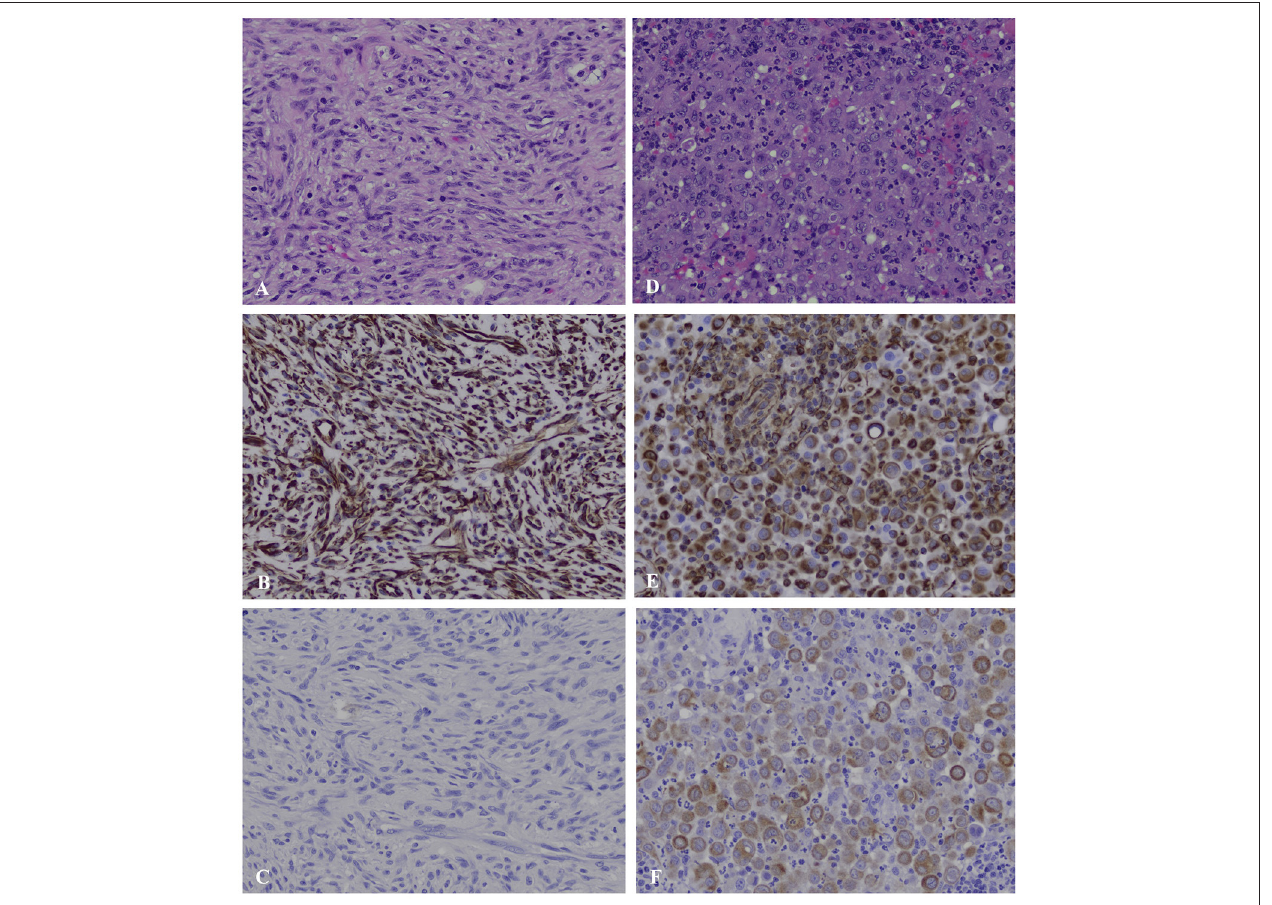
FIGURE 2 | Mediastinal mass (A–C) and sternal lymph node (D–F) , canine. (A) The mediastinal mass is composed of densely packed, disorganized, interwoven bundles and streams of neoplastic spindle cells on scant fibrous stroma (40X). (B) Immunohistochemistry for vimentin of the mediastinal mass shows strong intracytoplasmic labeling within neoplastic spindle cells. (C) Immunohistochemistry for cytokeratin of the mediastinal mass shows no labeling among the neoplastic spindle cells. (D) The subcapsular and medullary sinuses of the sternal lymph node are infiltrated by sheets of pleomorphic round cells exhibiting marked anisocytosis and anisokaryosis, frequent binucleation in which the nuclei are squished together creating a flattened appearance of their coalescing borders, and emperiopolesis. (E) Immunohistochemistry for vimentin of the sternal lymph node shows strong intracytoplasmic labeling within pleomorphic round cells. (F) Immunohistochemistry for cytokeratin of the sternal lymph node shows moderate to strong intracytoplasmic labeling within pleomorphic round cells.